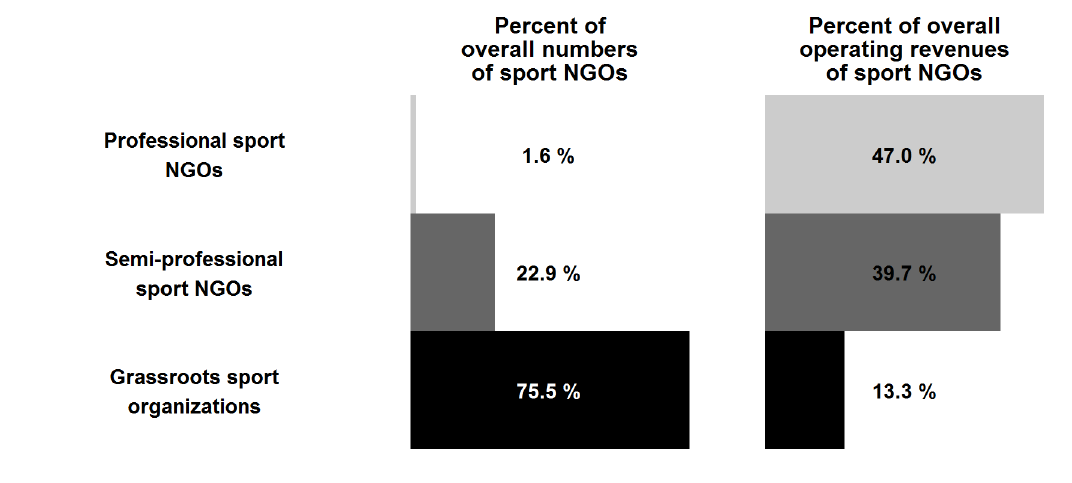
Figure 2. Share in overall operating revenues by three groups of sport